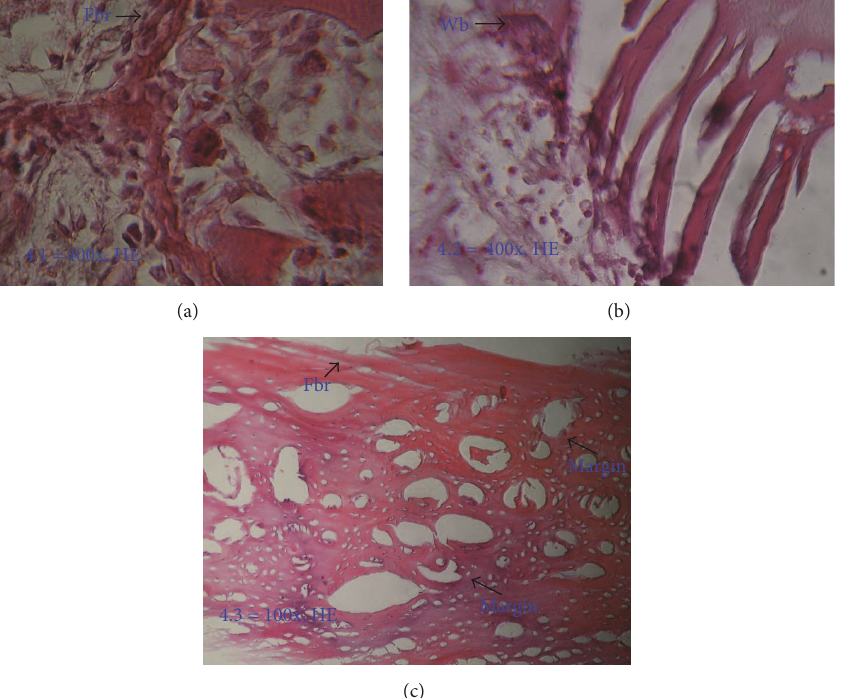
Figure 14: Histology of white rabbit’s femur (diaphysis) in demineralized bone matrix bovine group. (a) In week 1, high amount of woven bone and fibrous tissue; (b) in week 2, decrease of fibrous tissue and woven bone; (c) in week 4, unclear margin between woven bone and native bone, representing calcified woven bone. Fbr: fibrous tissue; Wb: woven